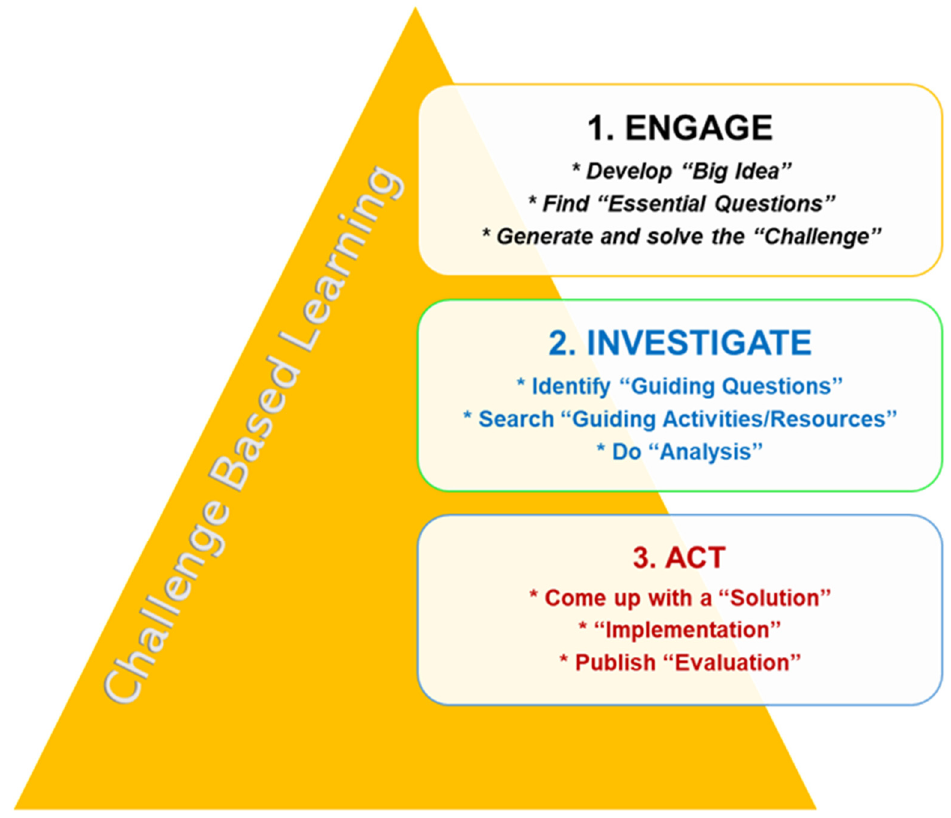
Figure 1. The three phases of CBL (adapted from Nichols et al., 2016) [2] .